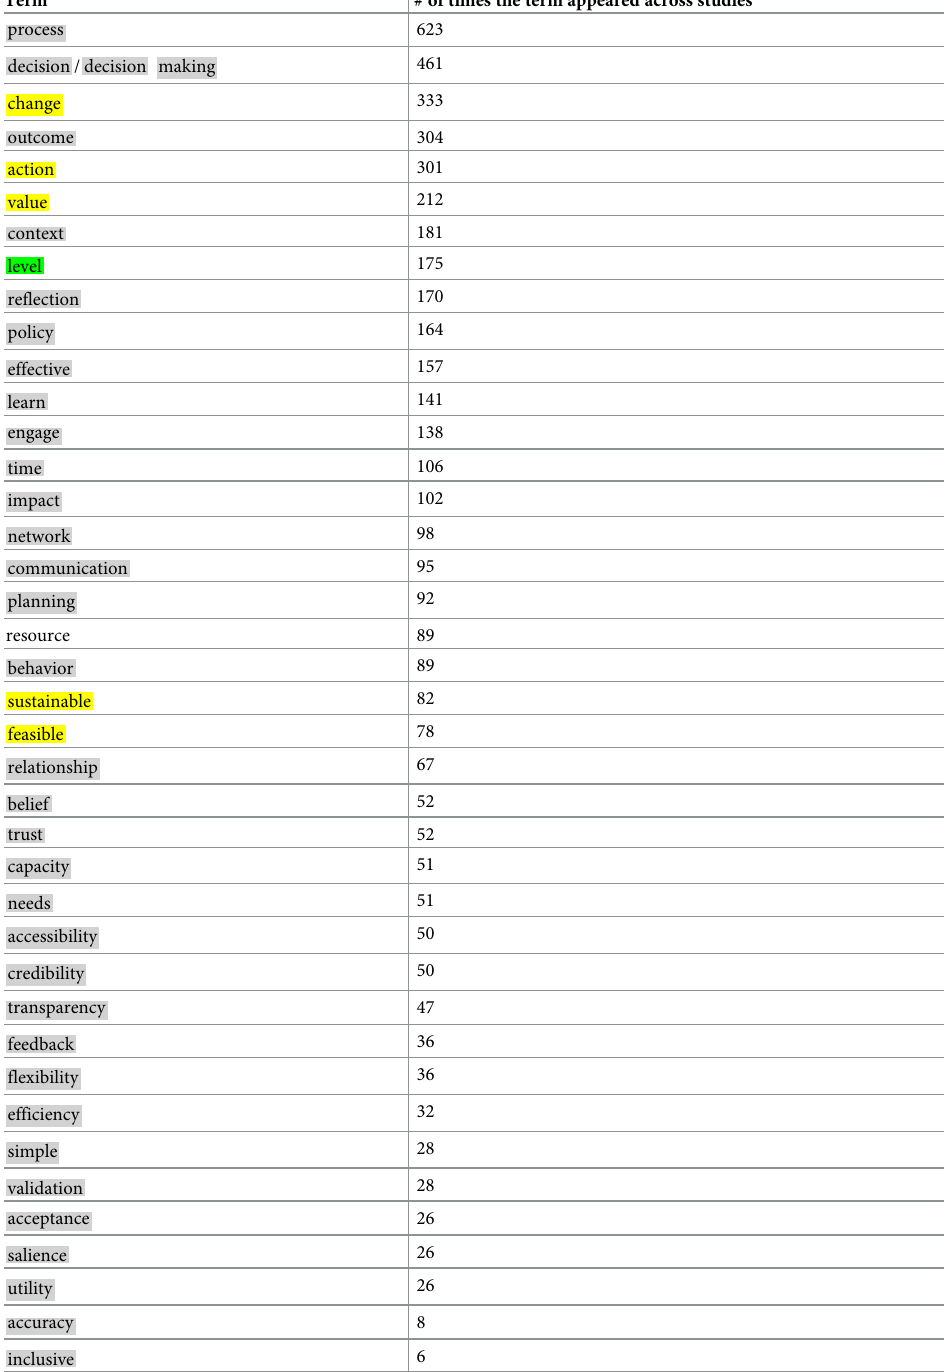
inclusive Yellow highlight suggests common themes that have formed the overall evaluation framework categories; grey highlight suggests common sub-themes that have been incorporated as evaluation criteria; green highlight suggests the consideration of multiple evaluation levels (e.g., project vs system level) to be embedded within the evaluation